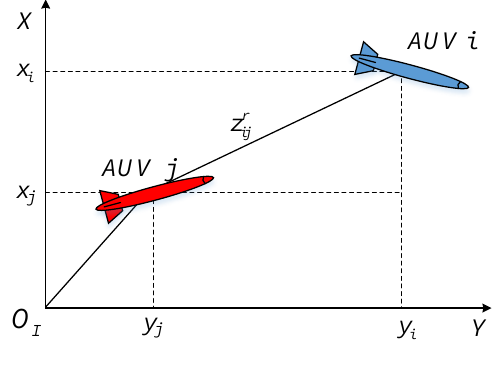
Figure 5. Position